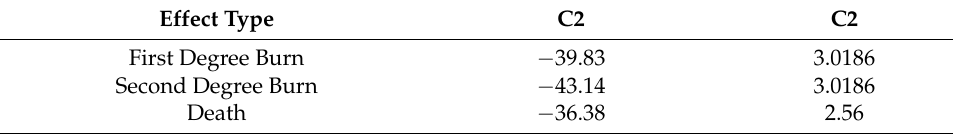
Table 3. Probit function coefficients [30].